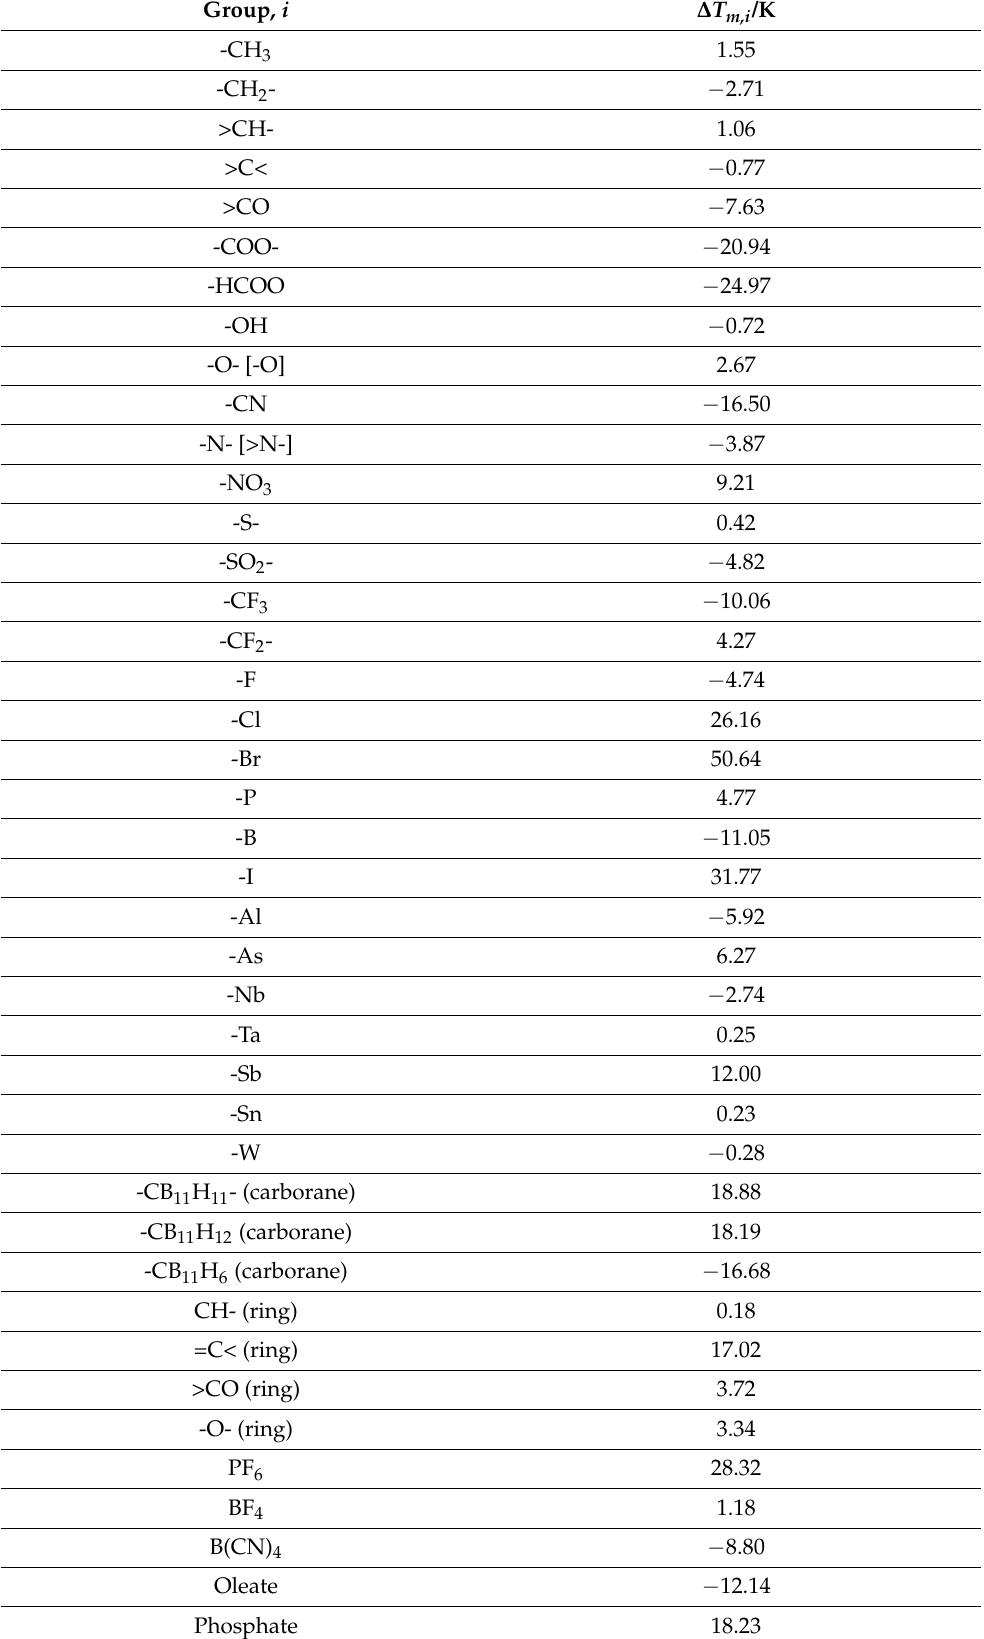
Table 3. New and reparametrized anion functional group parameters for